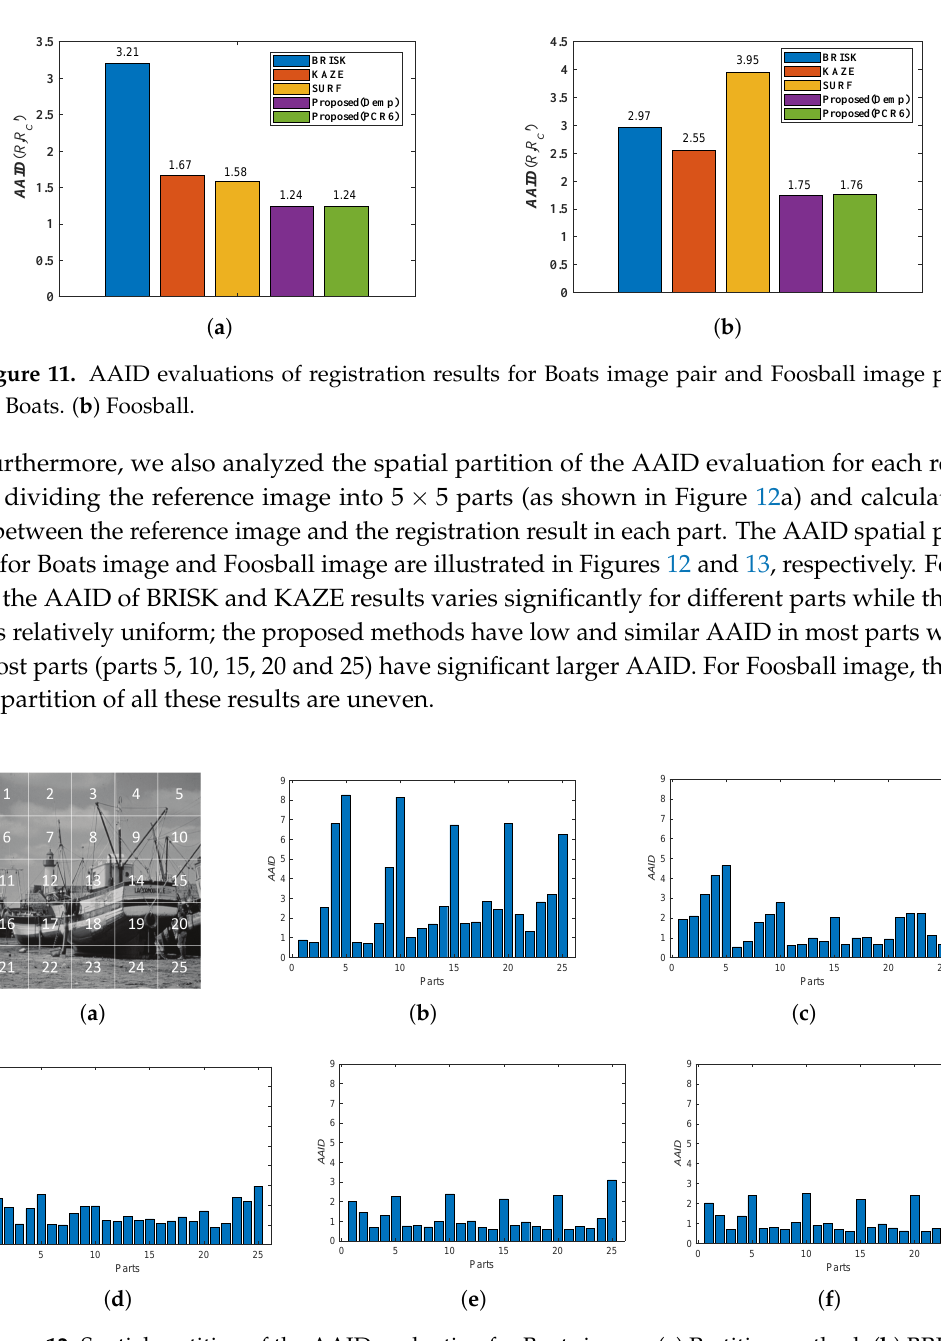
Figure 12. Spatial partition of the AAID evaluation for Boats image. ( a ) Partition method. ( b ) BRISK. ( c ) KAZE. ( d ) SURF. ( e ) Proposed (Demp). ( f ) Proposed